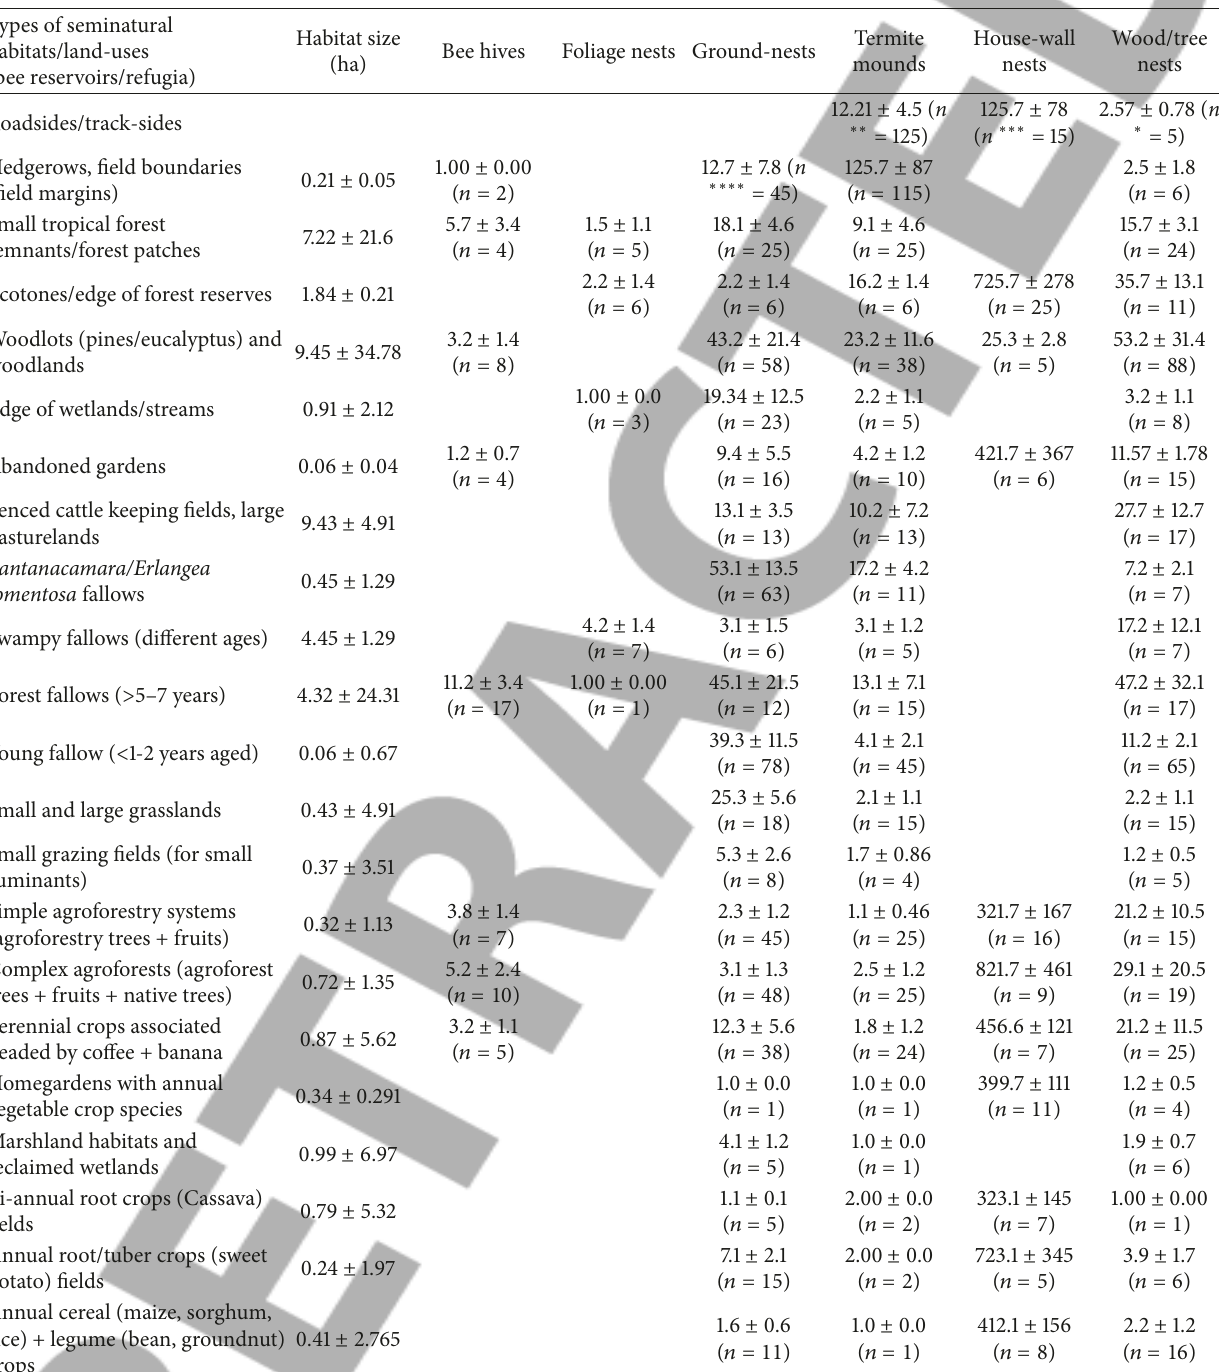
Table 4: Density ( x ± sd) of bee nests (number of individual bee nests counted during transects walks and counts different farmland habitats/land-uses) per nesting